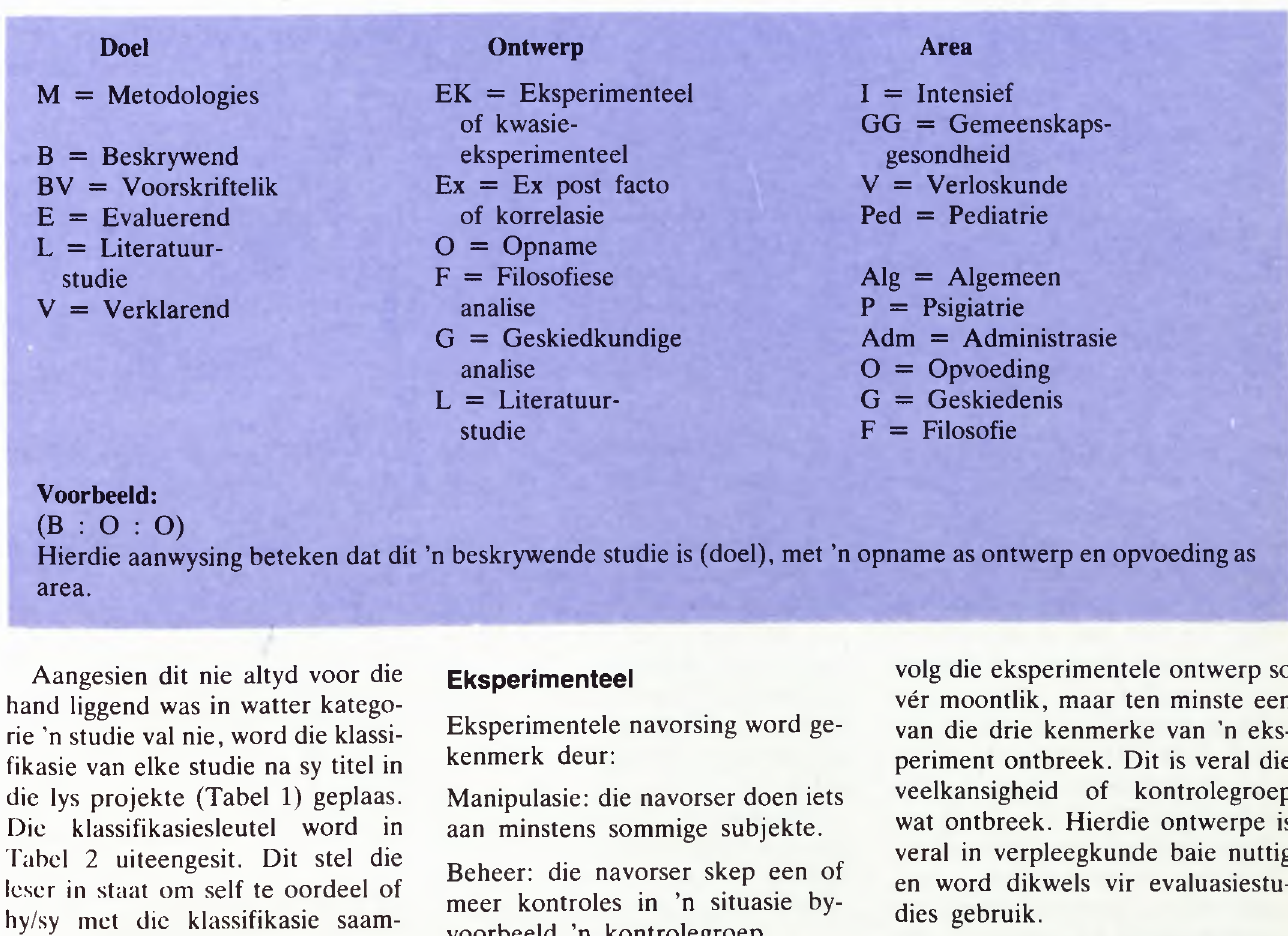
Tabel 2 uiteengesit. Dit stel die lescr in staat om self te oordeel of hy/sy met die klassifikasie saam- stem of